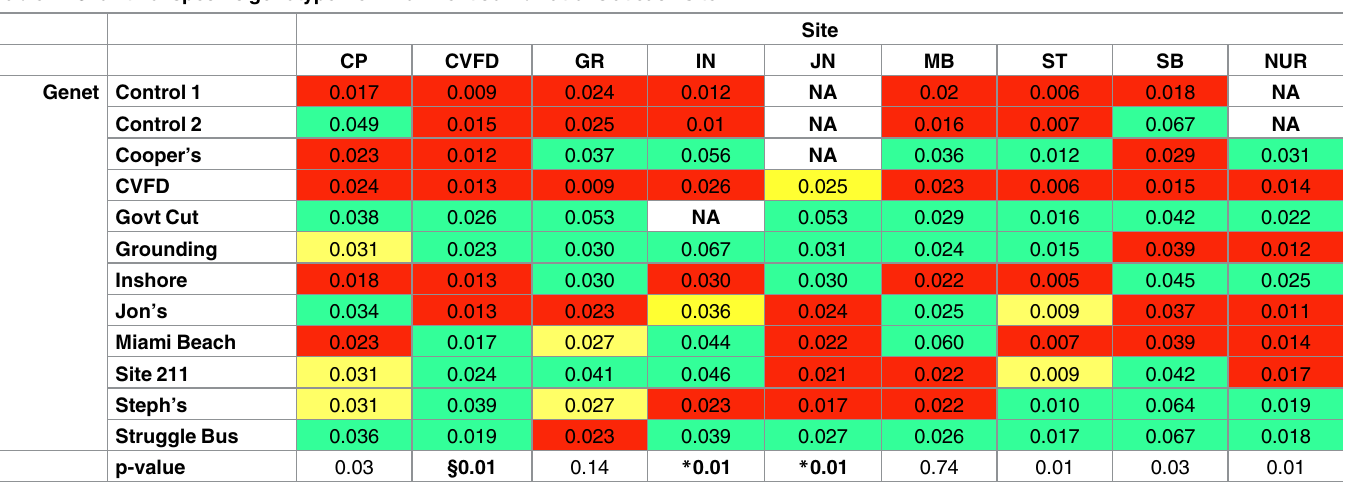
Table 1. Growth of specific genotype x environment combinations at each site.